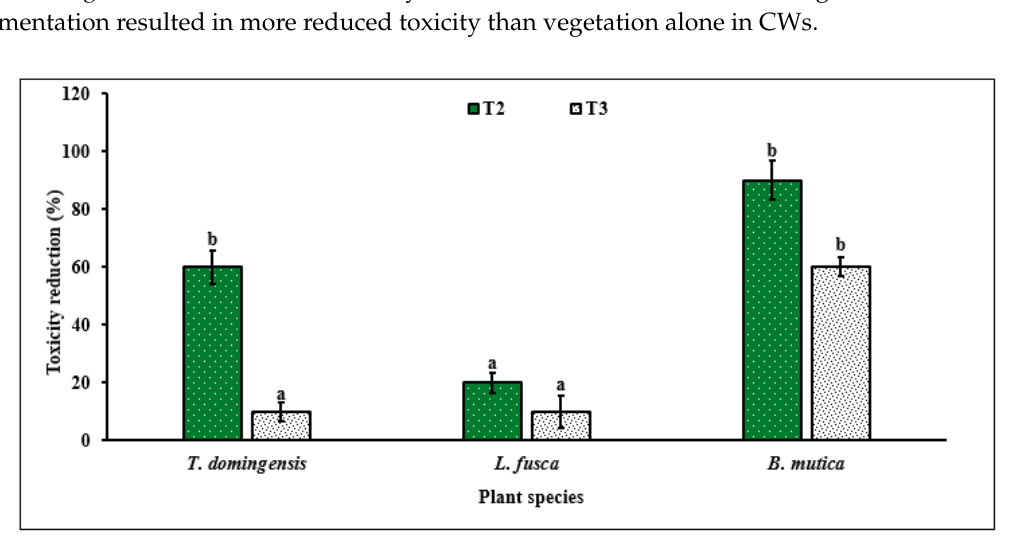
Figure 5. Morphological change in C. idella on exposure to tannery effluent before ( A ) and after treatment ( B ) by CW technology.